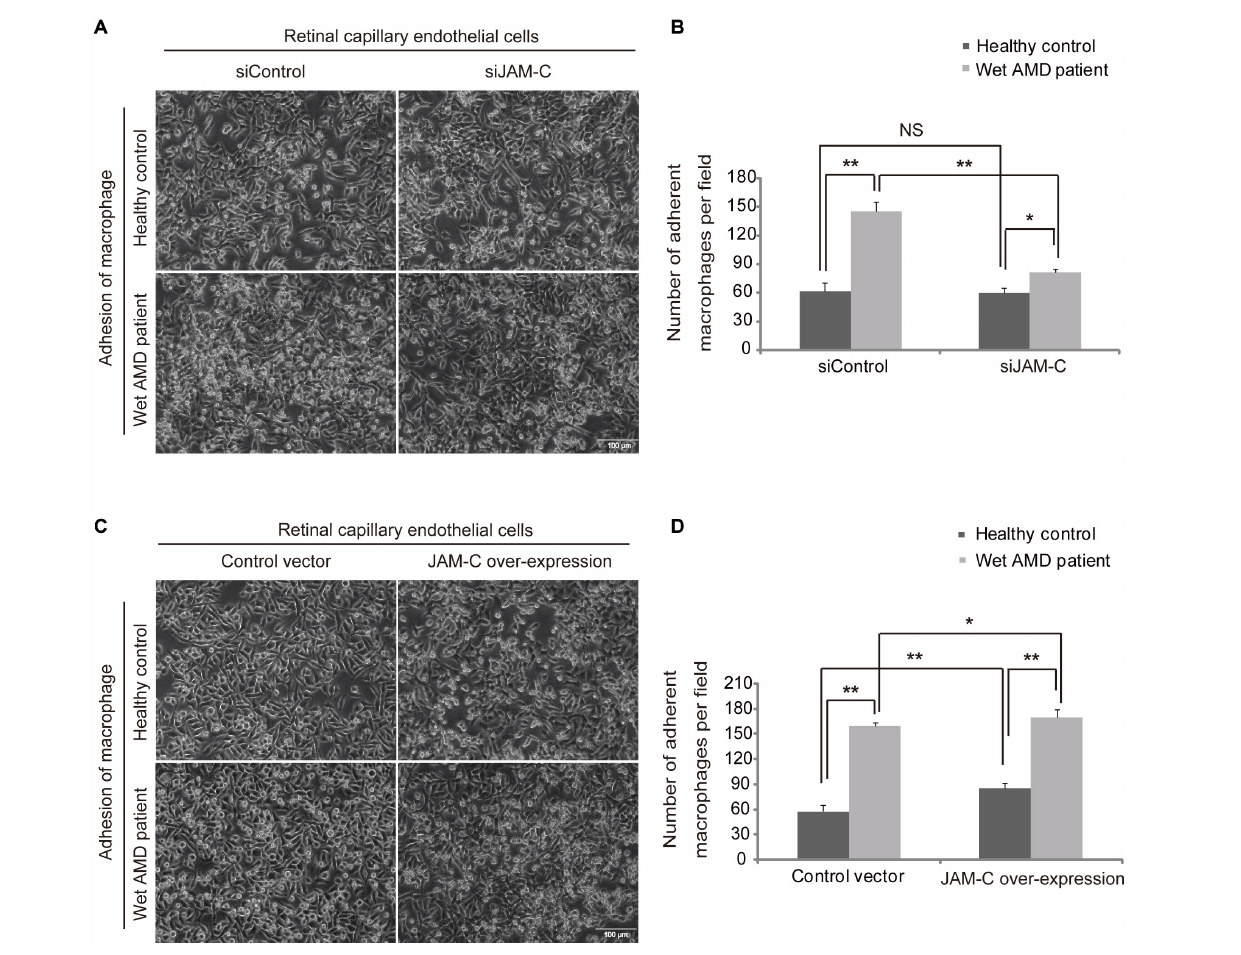
FIGURE 4 | JAM-C regulates macrophage adhesion to human RCECs. Macrophages from wAMD patients or healthy controls were added to culture plate wells containing a confluent monolayer of human RCECs, and the plates were incubated for 1 h. After washing the wells with PBS, adherent cells in five random fields were counted. Adherent macrophages were identified based on the cell size and morphology. (A,B) JAM-C knockdown in RCECs inhibits the adhesion of macrophages (small and round in shape) from wAMD patients to RCECs, but not those from healthy controls. The adhesion ability of macrophages from wAMD patients in both the siControl and siJAM-C groups increased compared to that of macrophages from healthy controls. (C,D) JAM-C overexpression increased the adhesion of macrophages from both wAMD patients and healthy controls. The adhesion ability of macrophages from wAMD patients in both the control and JAM-C overexpression groups increased compared to those from healthy controls. Scale bar: 100 µ m, * P < 0.05, ** P < 0.01, NS, not